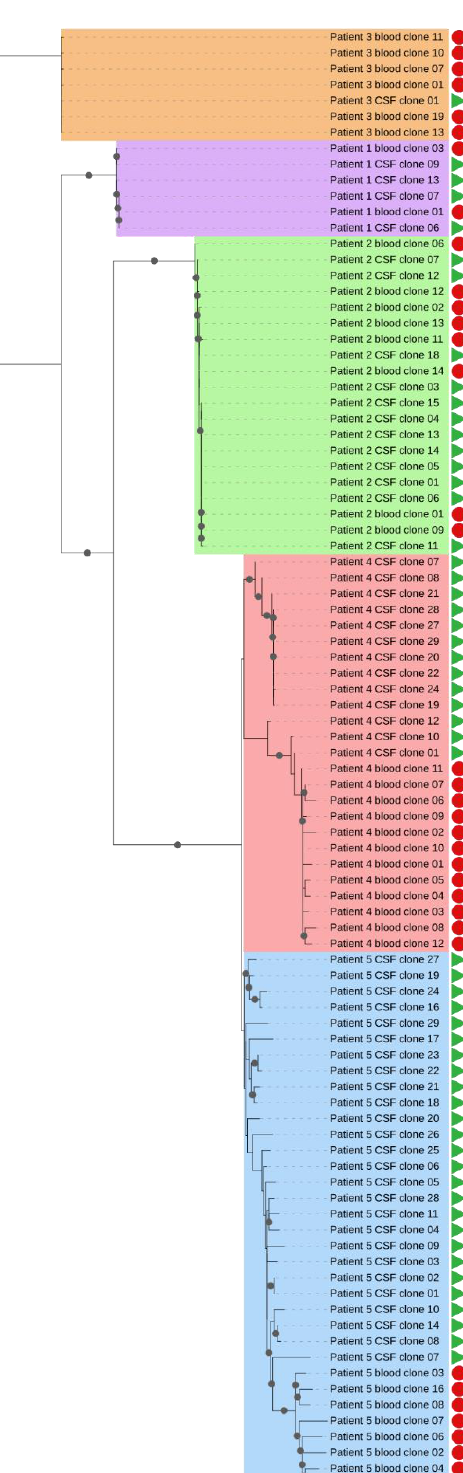
Figure 1. Phylogenetic analysis of the hepatitis E virus quasispecies in the blood and the cerebrospinal fluid of the five patients. The neighbor-joining tree was produced using the maximum likelihood distance clone sequences. The phylogenetic trees were visualized with iTOL. Black dots represent the nodes with bootstrap values >70.